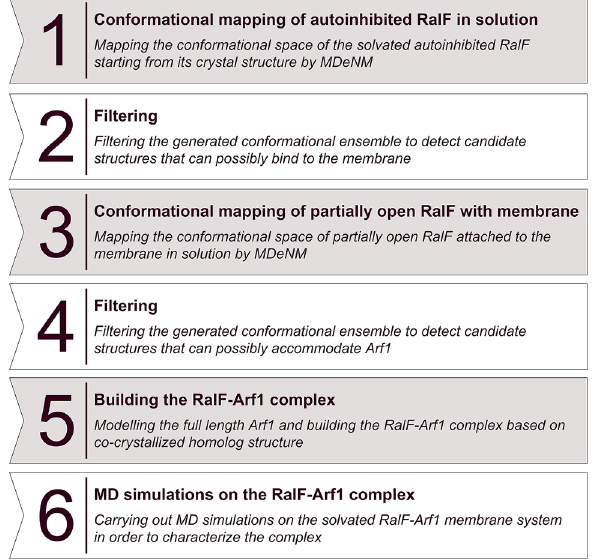
Figure 1. The steps of the modelling process starting from the autoinhibited, closed RalF and resulting in the relaxed, membrane-attached RalF-Arf1